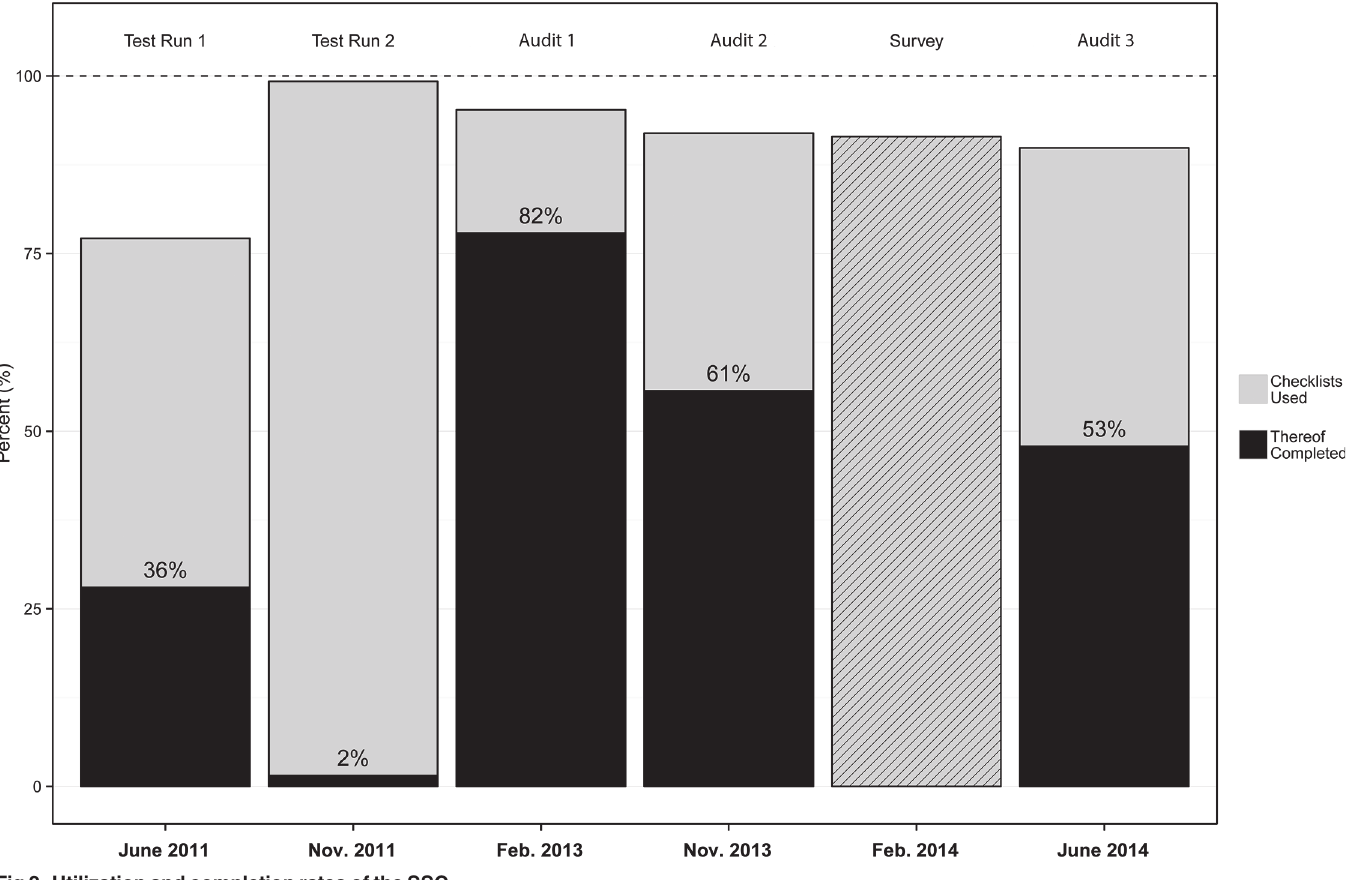
Fig 2. Utilization and completion rates of the